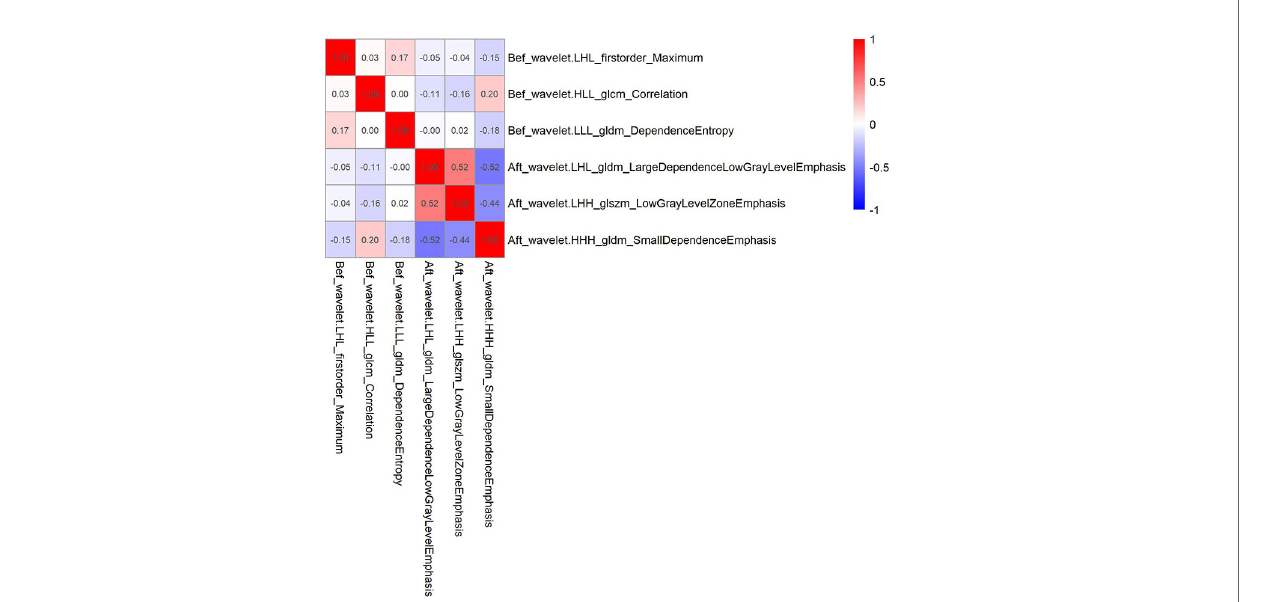
FIGURE 1 | Correlation coef fi cient between 6 radiomics features screened by Lasso regression in the training